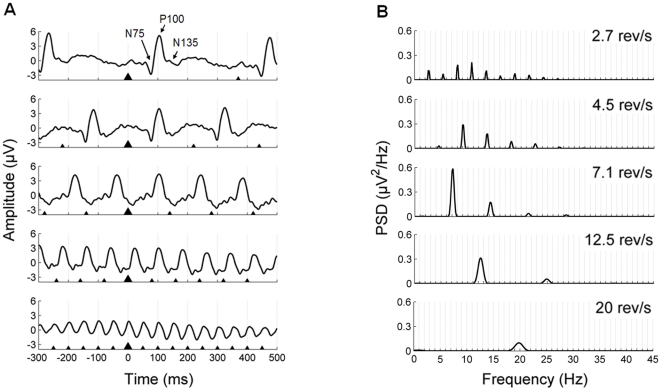
Recorded isochronic waveforms (Experiment 1).
A, Grand-average waveforms (800 ms time window, including 300 ms pre-stimulus activity) for the five isochronic conditions. The typical deflections of the pattern reversal ERP (N75 at 70–90 ms, P100 at 80–120 ms and N135 at 120–180 ms) are indicated in the grand-average for the 2.7 rev/s condition. The triangles placed below the waveforms indicate the timing of stimuli appearance; the largest triangle represents the zero time point. B, Power spectral densities of the grand-average waveforms for the five isochronic conditions.